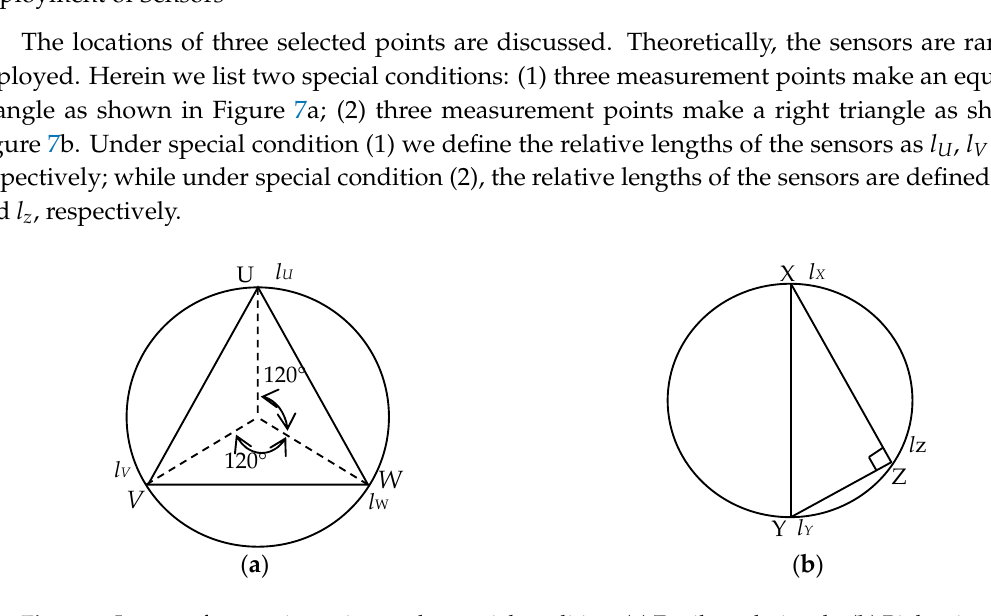
Figure 7. Layout of measuring points under special condition: ( a ) Equilateral triangle; ( b ) Right triangle.